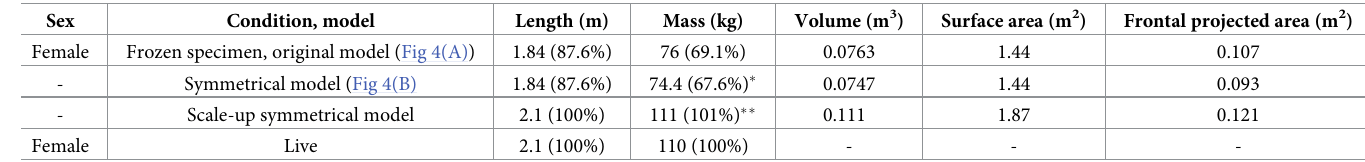
Table 1. Morphological parameters of dolphins ( Lagenorhynchus obliquidens ) and 3-D models.